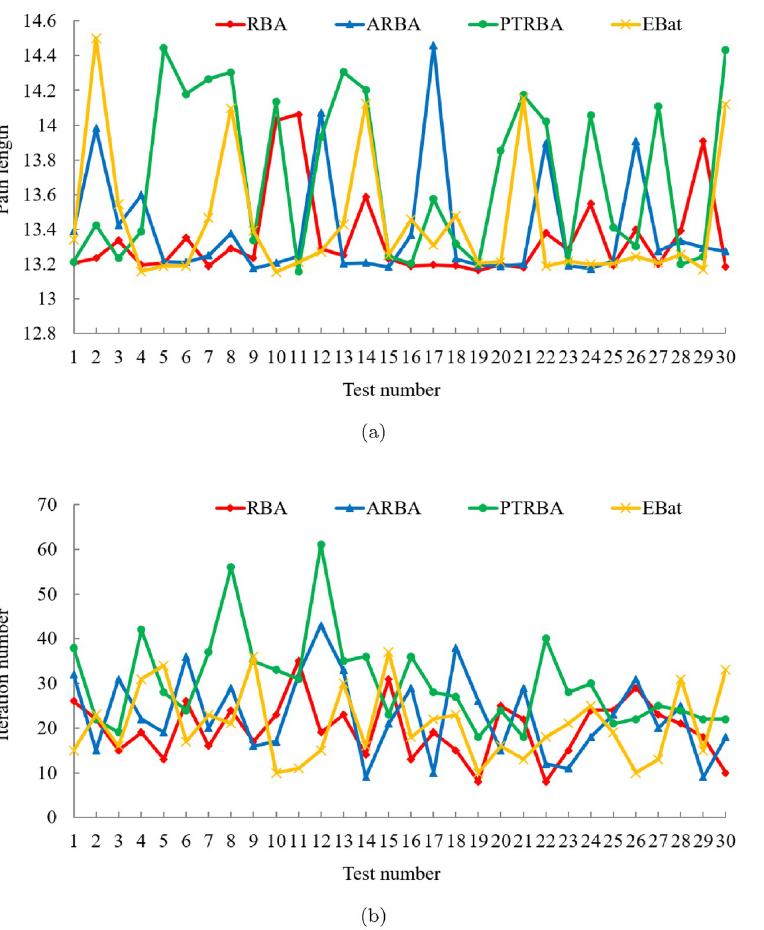
Fig 8. Experimental results of four algorithms in test case 2. (a) Path length. (b) Iteration number.